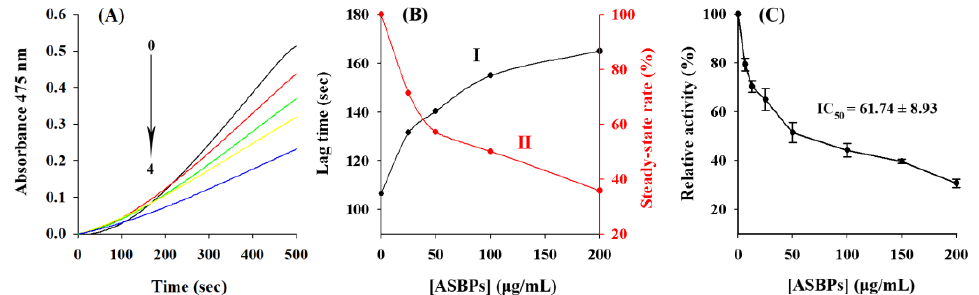
Figure 4. ( A ) Progress curves for the inhibition of monophenolase activity in tyrosinase by ASBPs; Effect of ASBPs on the ( B ) lag time and steady-state rate of monophenolase activity and ( C ) diphe- nolase activity in tyrosinase. Curves 0 – 4 represent ASBPs concentrations of 0, 25, 50, 100 and 200 µg/mL, respectively.